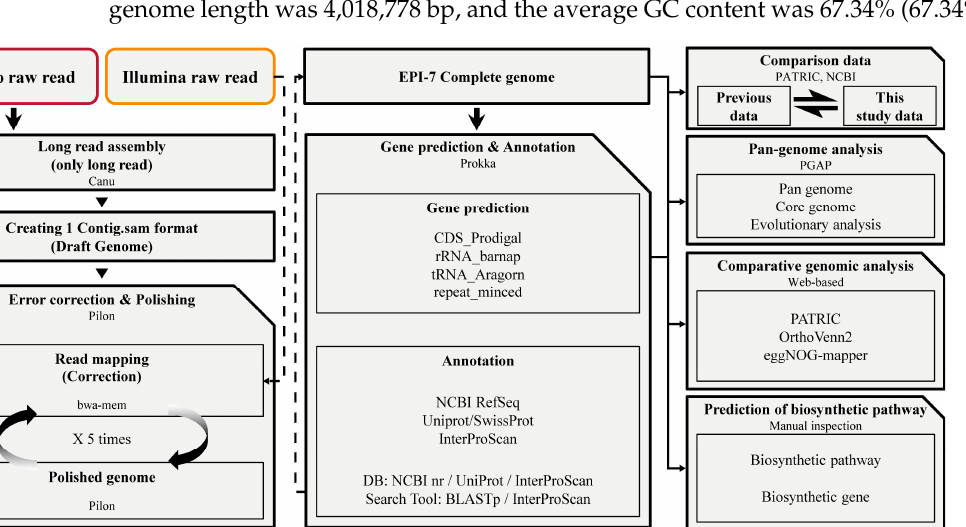
Figure 1. A comprehensive analysis was performed at each stage to understand Epidermidibacterium keratini EPI-7 T . Step 1. Construction of new E. keratini EPI-7 T genome using PacBio raw read